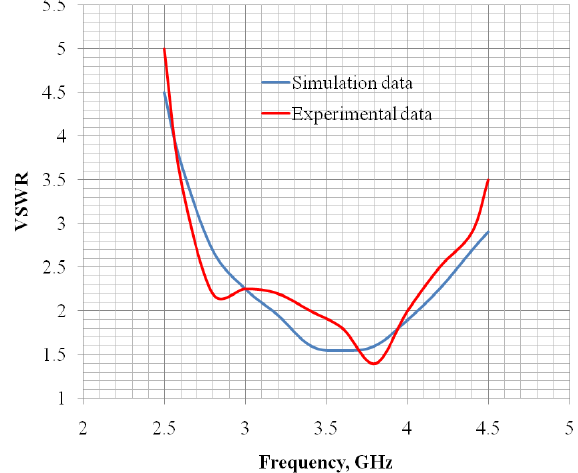
Fig. 3 . Frequency responce of VSWR of the symmetric dipole with triangular shoulders: simulation and experimental data.